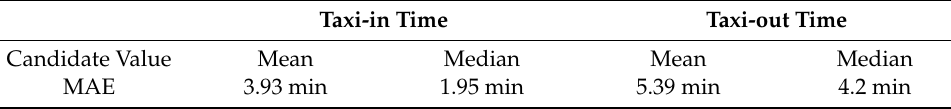
Table 9. MAE Statistical Results.